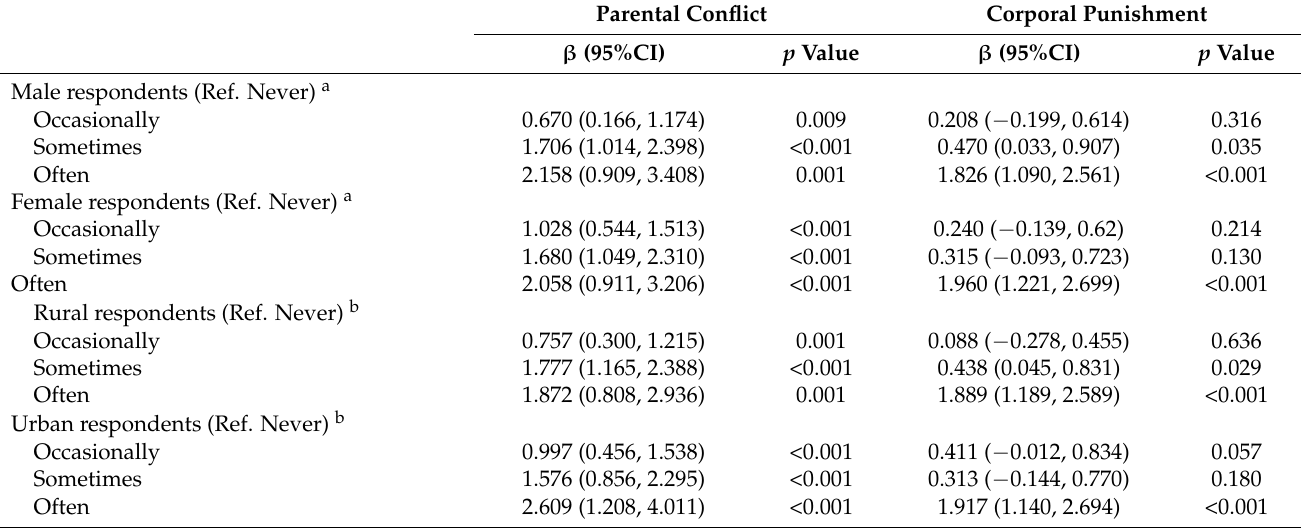
Table 5. Subgroup